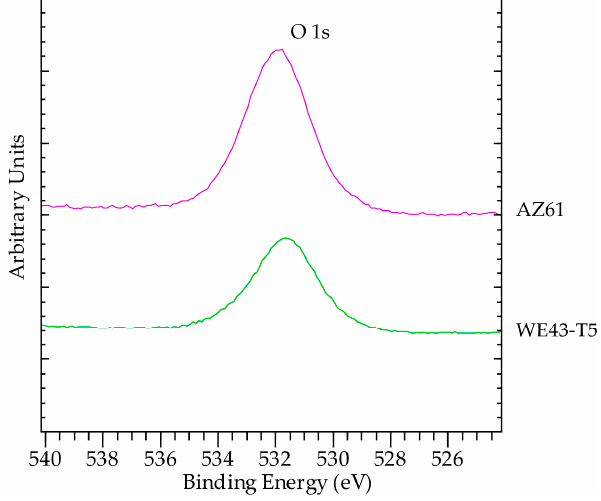
Figure 15. High resolution O1s scans. The peak position corresponds to OH - and/or adsorbed spe-